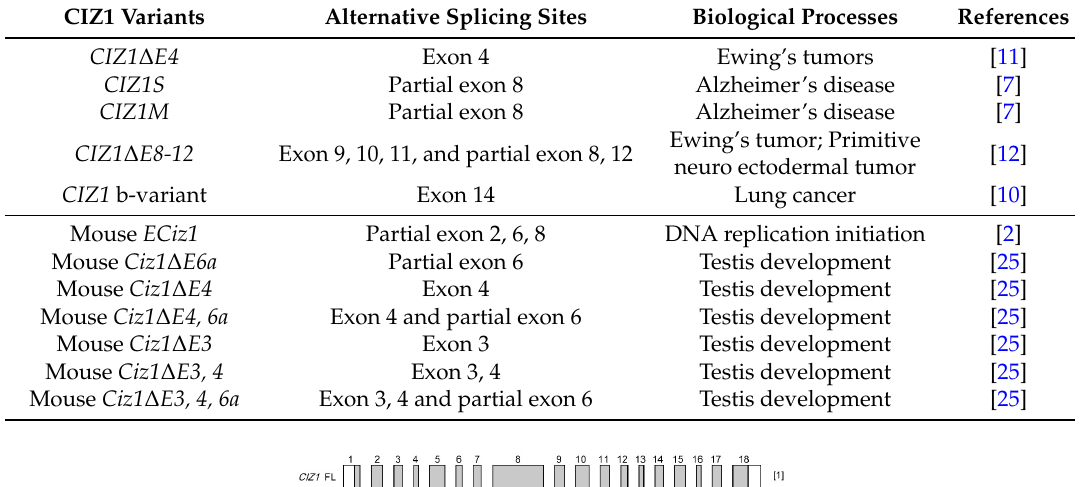
Table 1. Alternative splicing patterns of CIZ1 mRNA.